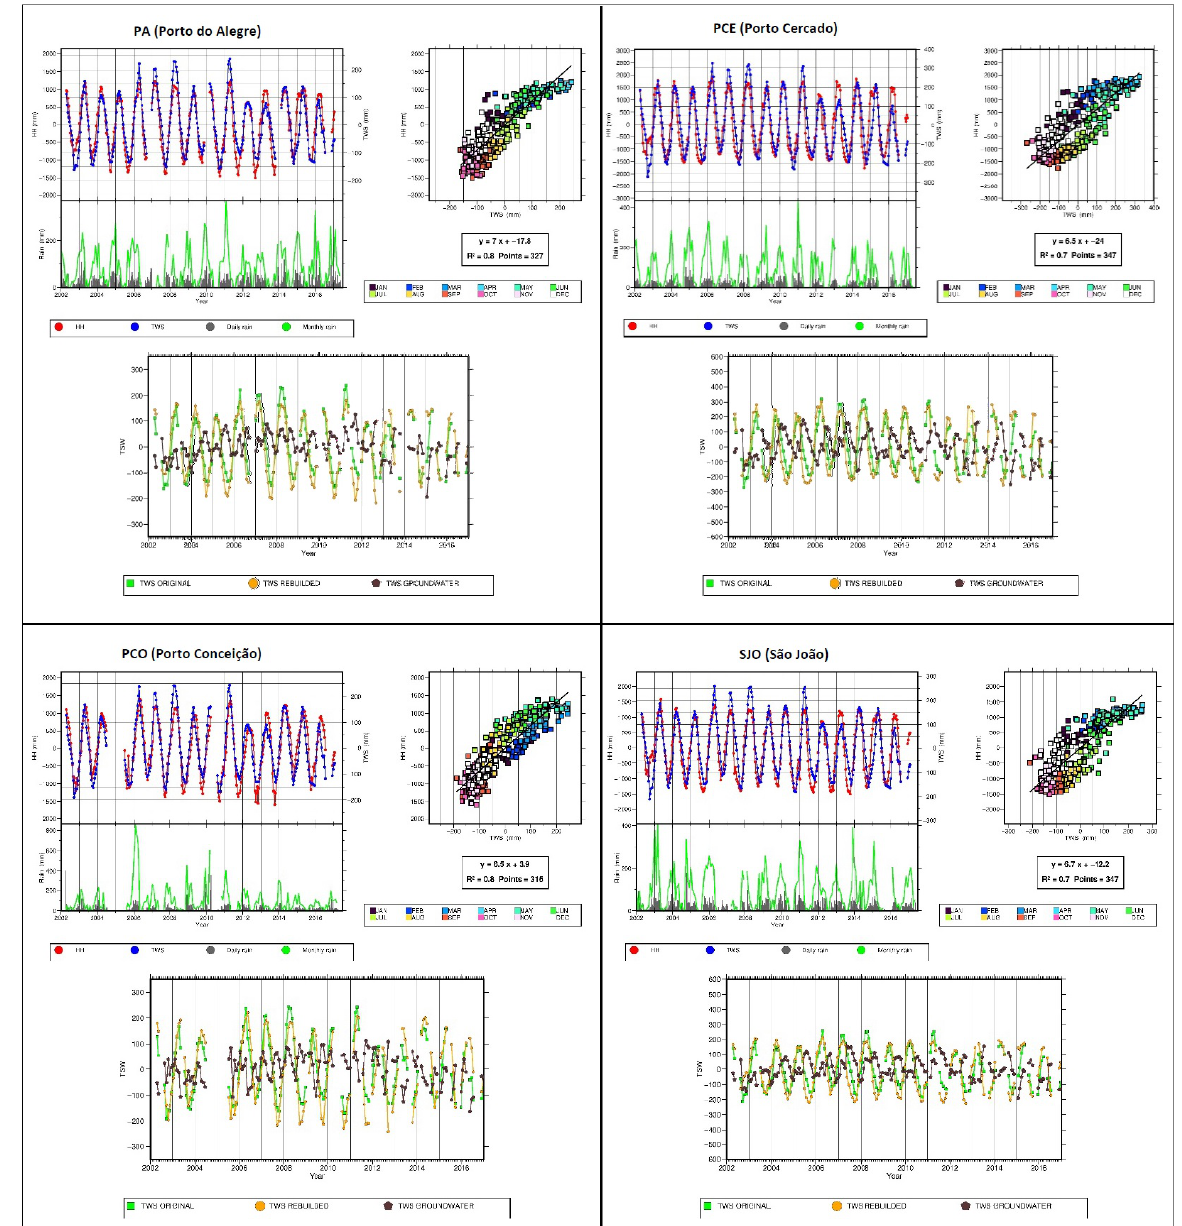
Fig. 9. Time series, determination coefficient and adjustment line, monthly TWS-HH connection and groundwater variation for six river gauge stations selected in the Pantanal area (Mato Grosso State), period 01/2002- 11/2016.